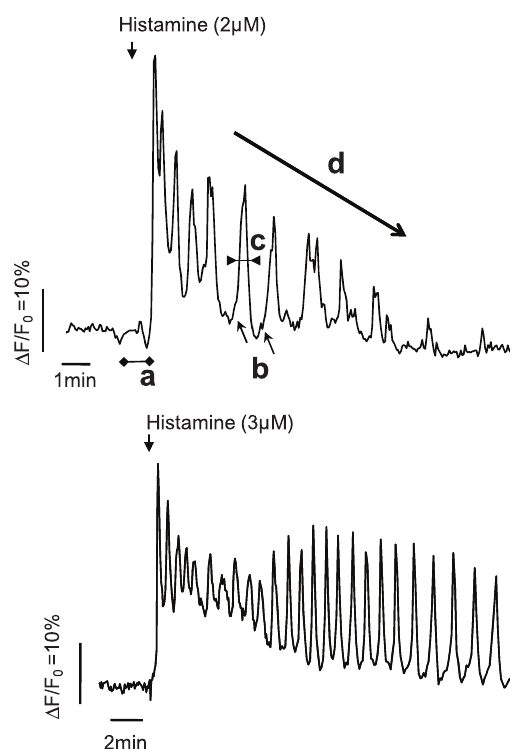
Figure 2. Various characteristics of Ca 2+ oscillations that participate in fine tuning. Traces show typical curves of Fluo4 loaded HeLa cells challenged with either 2 µM histamine (upper trace) or 3 µM (lower trace). Calcium imaging was performed as described previously 10 . Fluorescence images were collected every 3 seconds by an EM-CCD camera (Hamamatsu), digitized, and integrated in real time by an image processor (Metafluor). Letters indicate characteristics of Ca 2+ oscillations that, besides their frequency, can affect the cellular response to these repetitive Ca 2+ increases (a: latency of the Ca 2+ response to the stimulation, b: minimal Ca 2+ level between the spikes or baseline Ca 2+ , c: duration, or half-width, of the spikes, and d: rate of decrease of the response or degree of